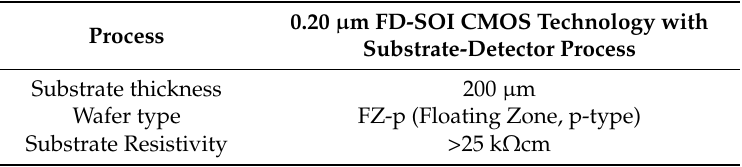
Table 1. SOIPIX Process